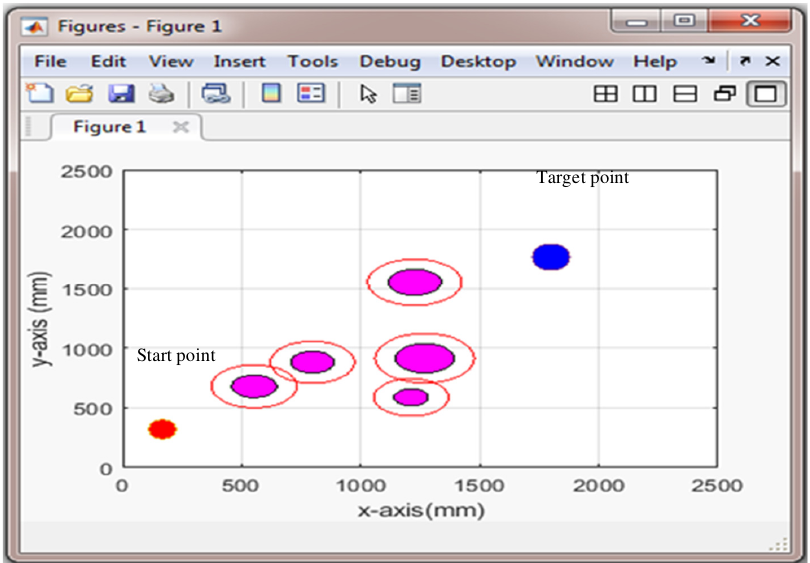
Fig. 3. The Environment of Case